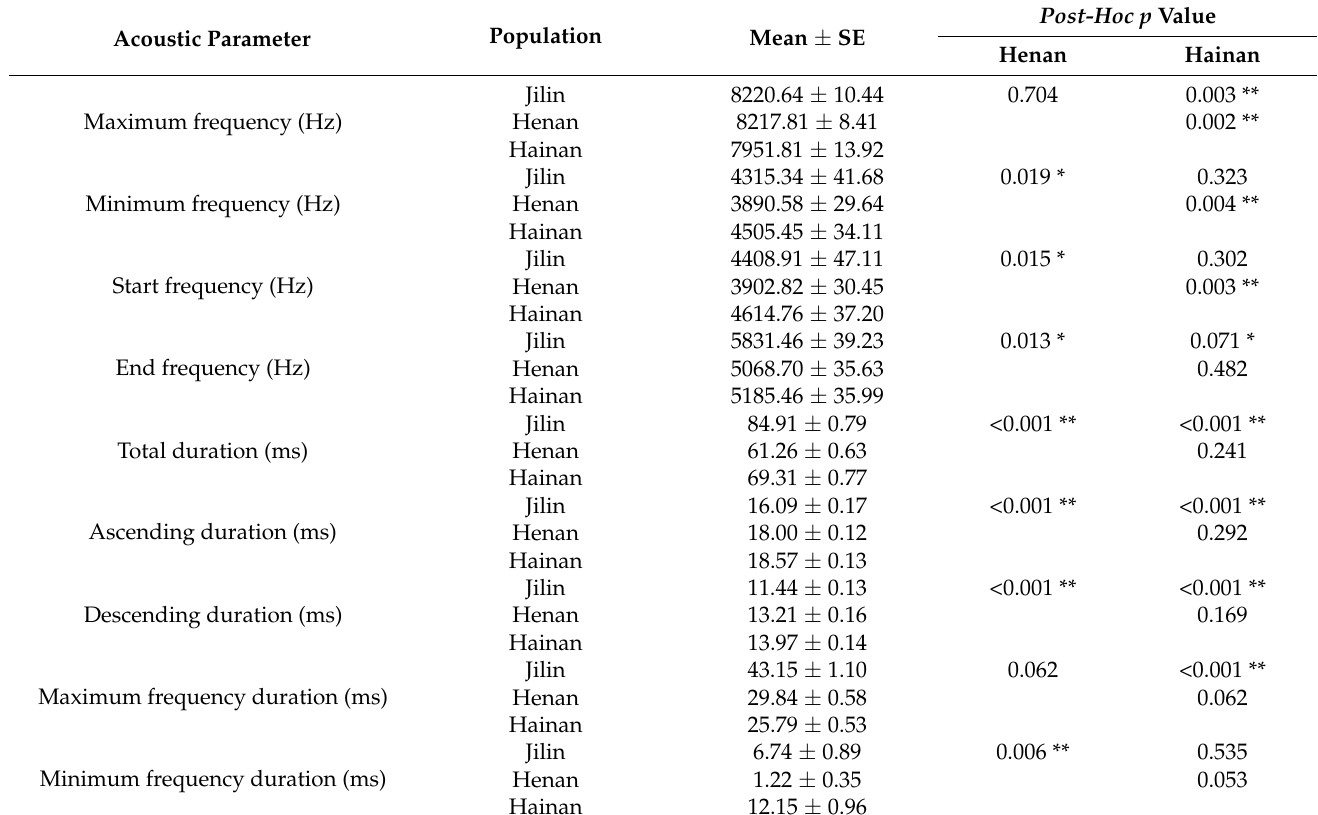
Table 2. The results of comparisons of the acoustic parameters of A notes in alarm calls of Japanese